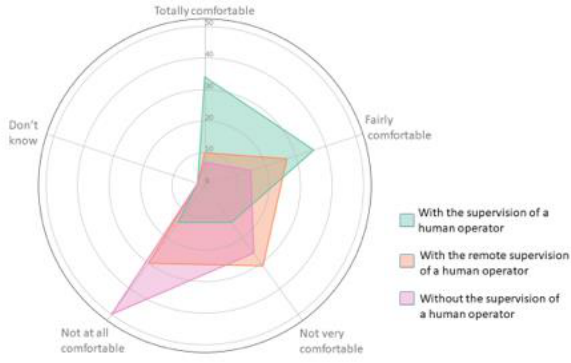
Fig. 4. Responses to the question “Would you feel comfortable travelling in a fully automated vehicle..?” in the Eurobarometer Survey 496